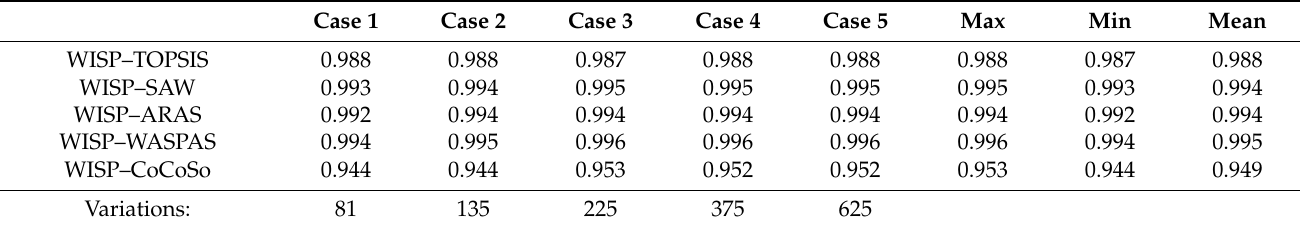
Table 12. The correlation between ranking orders of alternatives.